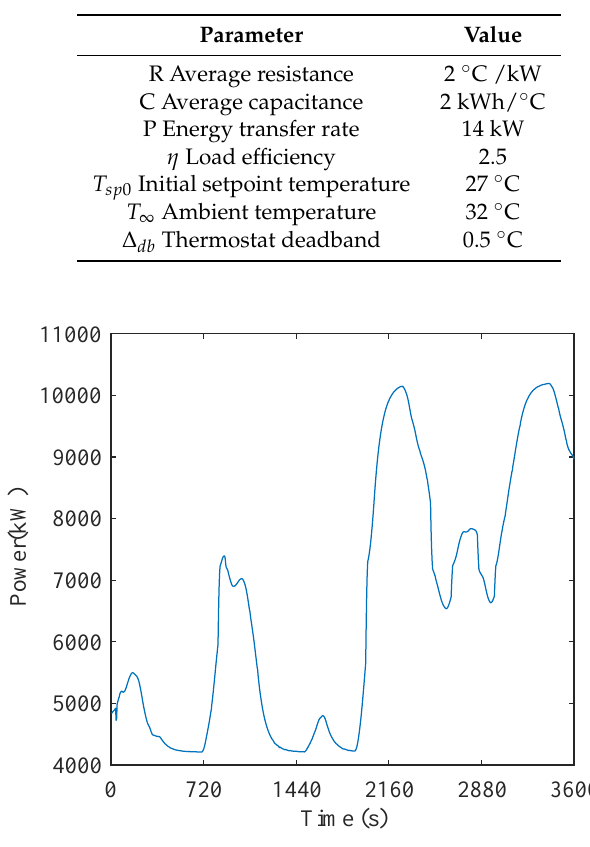
Table 2. Parameter values for the numerical simulations.